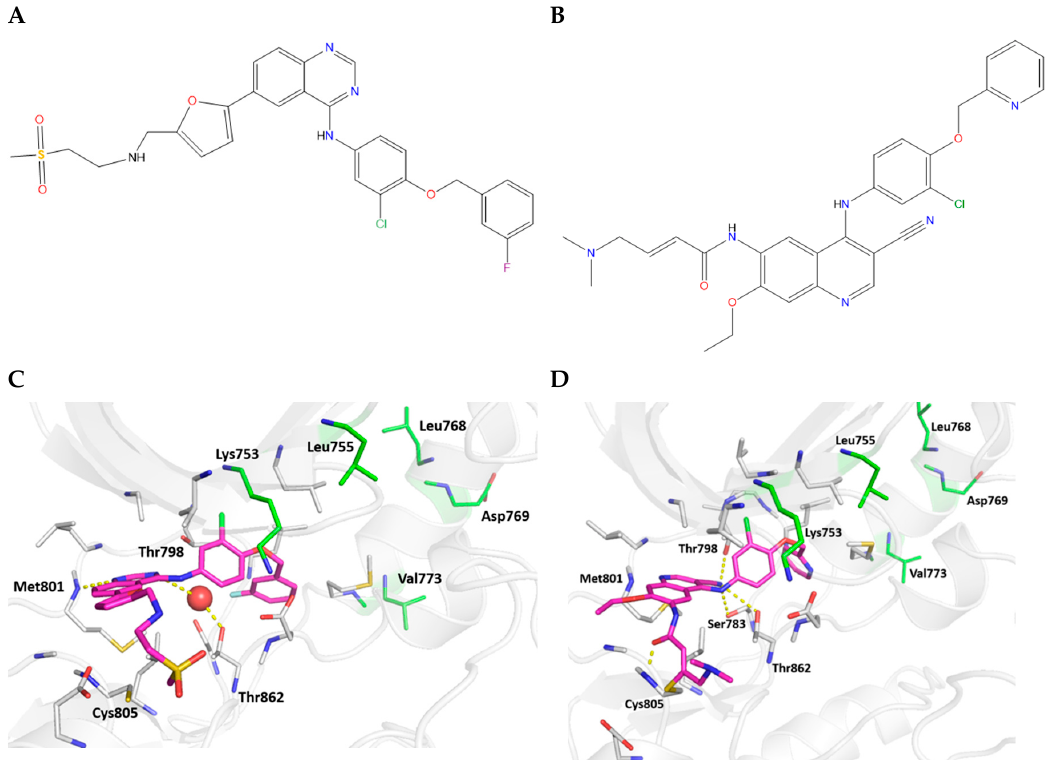
Figure 2. Chemical structures of ( A ) lapatinib and ( B ) neratinib. Modeled structures of the complexes between ( C ) HER2 and lapatinib and ( D ) HER2 and neratinib. The crystal structure of the HER2 kinase domain in its inactive form (PDB ID: 3PP0) was taken and lapatinib (guided by the crystal structure of the complex between lapatinib and HER4, PDB ID 3BBT) and separately neratinib (guided by the crystal structure of the complex of neratinib and EGFR, PDB ID 2JIV) were modeled into the binding pocket. Lapatinib and neratinib are shown as colored sticks, with carbon atoms in magenta, nitrogen atoms in blue, oxygen atoms in red, sulfur atoms in yellow, chlorine atoms in green, and fluorine atoms in cyan. Lapatinib is bound non-covalently, whereas neratinib is covalently attached to the sulfur of Cys805. All interacting residues are highlighted as thin sticks (gray carbon) and all interactions are highlighted as dotted lines (yellow). HER2 mutations that are resistant to lapatinib are highlighted (green carbon, stick representation). A key water molecule (red sphere, Panel C) that mediates interactions between lapatinib and HER2 is shown. Hydrogen bonds made by the ligands are shown as thick yellow dashes. Lapatinib is engaged in hydrophobic interactions, one hydrogen bond with the backbone amide of Met801 and one water-mediated hydrogen bond with the side-chain hydroxyl of Thr862. Neratinib is engaged in hydrophobic interactions, forming a hydrogen bond with the side chain of Ser783, a hydrogen bond with the side chain of Thr862, a hydrogen bond with the backbone of Cys805, and a hydrogen bond with the side-chain hydroxyl of the gatekeeper Thr798. Modeling, docking, and optimization using molecular dynamics simulations (250 ns simulations of each complex performed in triplicate) of the complexes were performed using standard methods ([43]; in the current study we used Amber [44] version 16 and the Amber ff14SB force field [45]). HER, human epidermal growth factor receptor.